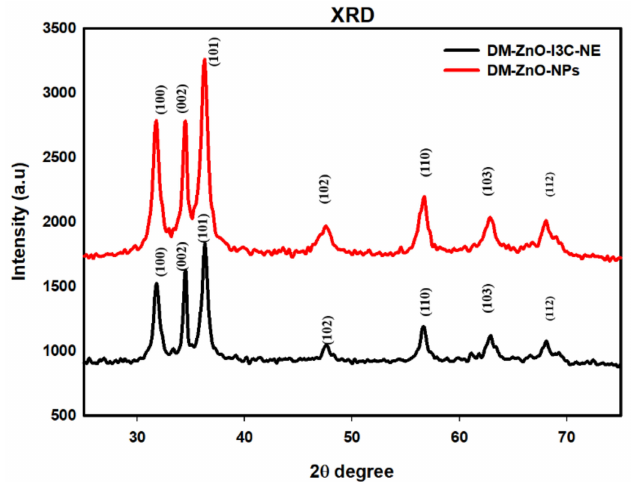
Figure 4. XRD analysis for DM -ZnO NPs (Red) and DM -ZnO-I3C-NE (Black).